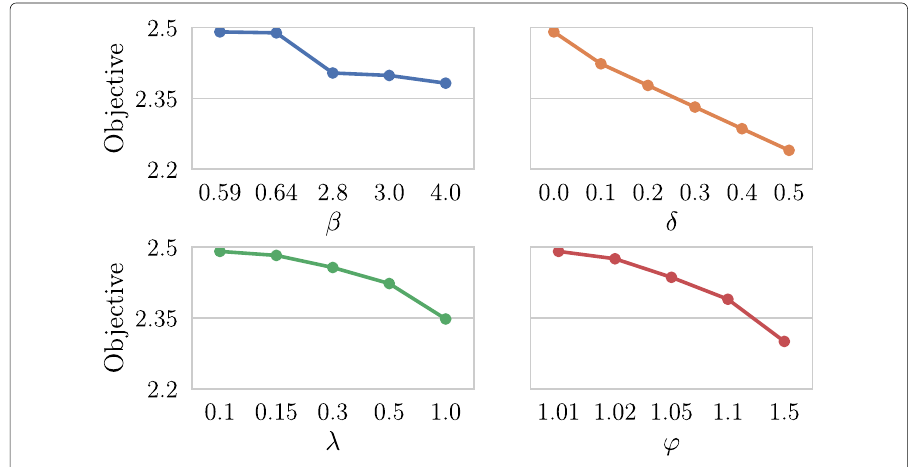
Fig. 11 Optimal objective function value under separate parameter